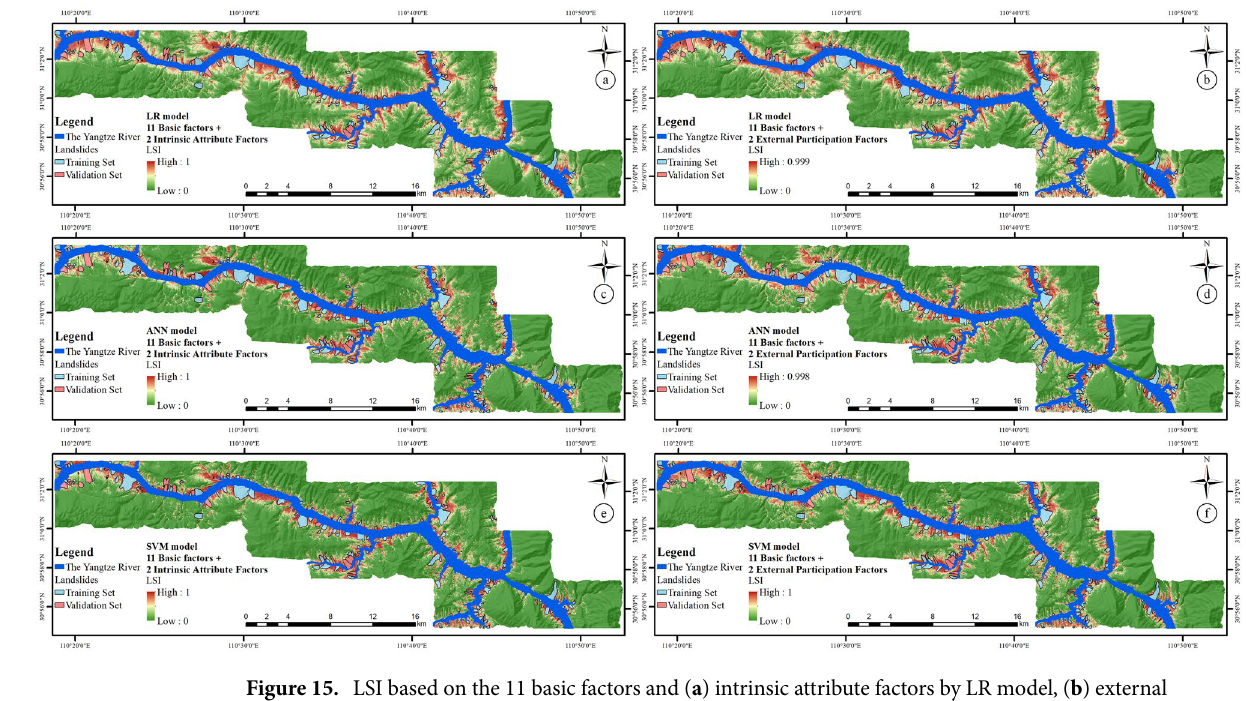
Figure 15. LSI based on the 11 basic factors and ( a ) intrinsic attribute factors by LR model, ( b ) external participation factors by LR model, ( c ) intrinsic attribute factors by ANN model, ( d ) external participation factors by ANN model, ( e ) intrinsic attribute factors by SVM model, and ( f ) external participation factors by SVM model.